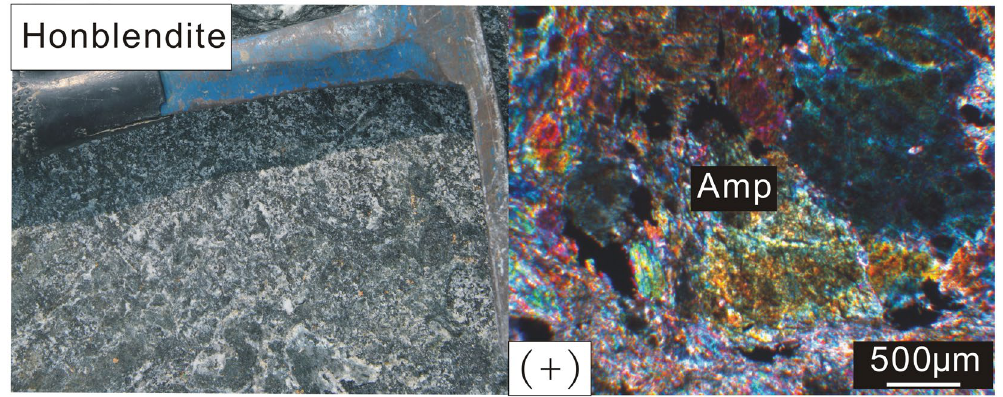
Figure 2. Field and microscope photographs for the hornblendites of the Cathaysia